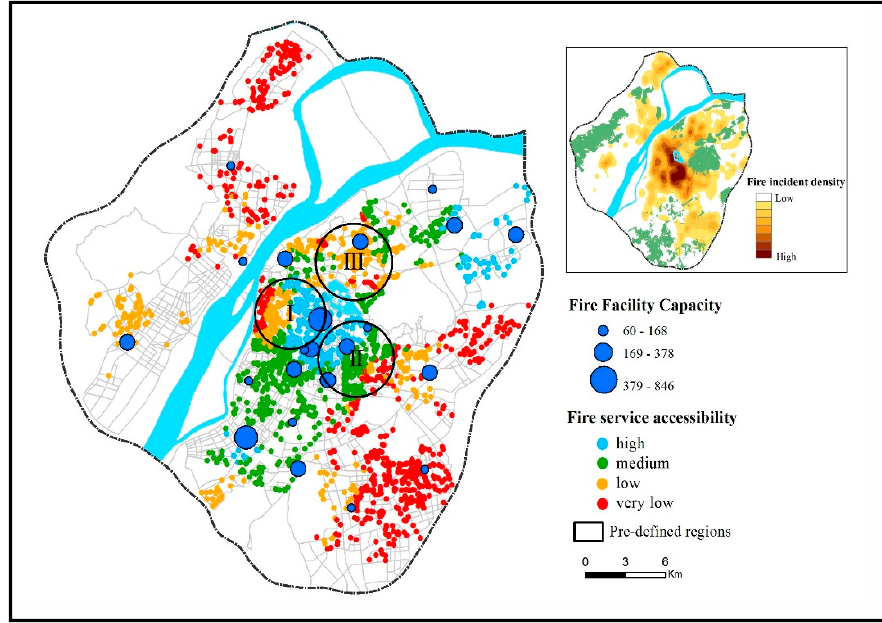
Figure 5. Spatial distribution of accessibility scores using the 2SFCA method incorporating additional spatial factors.